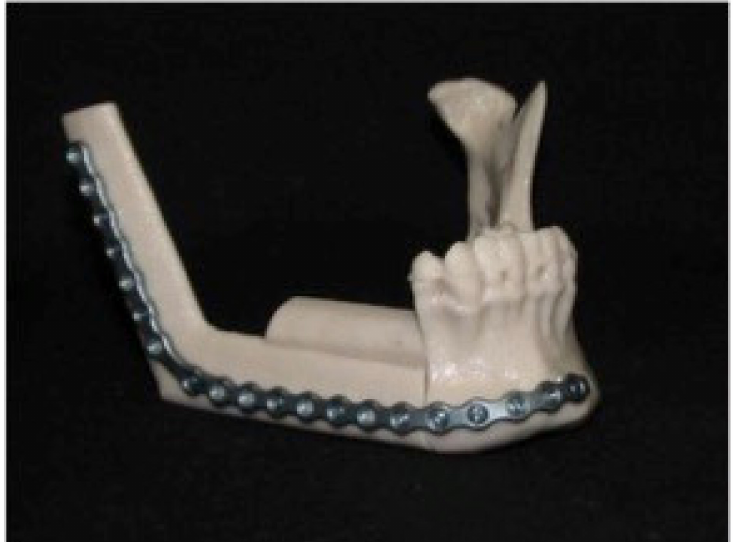
Figure 3. The titanium plate is shaped on 3D printed